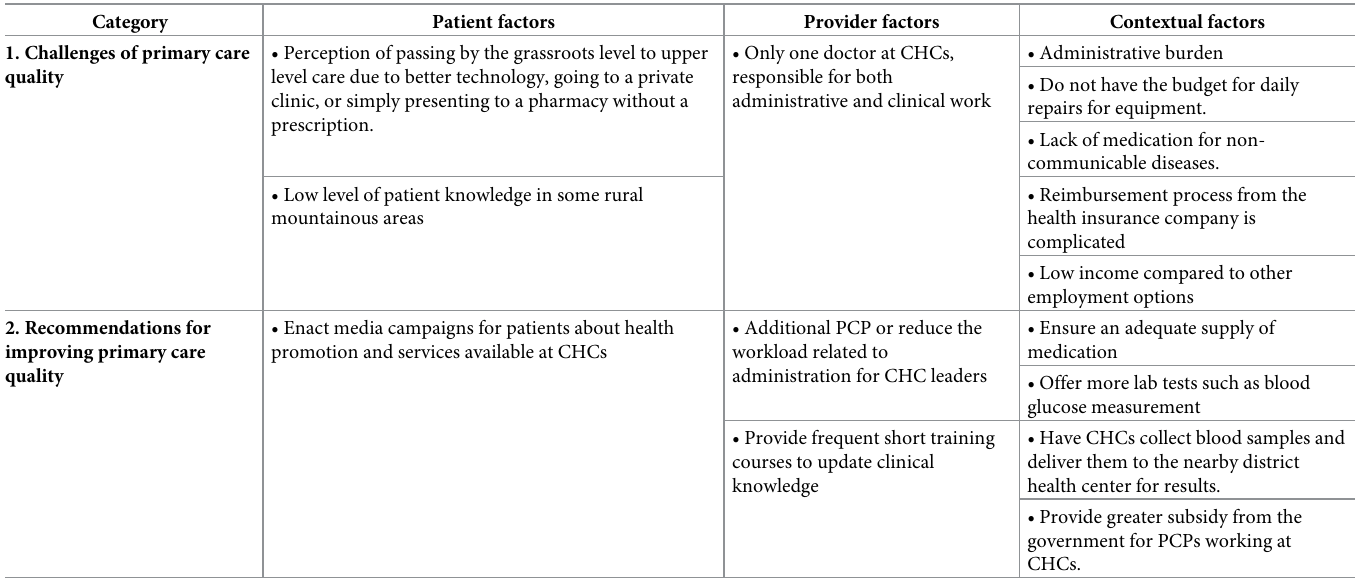
Table 4. Thematic